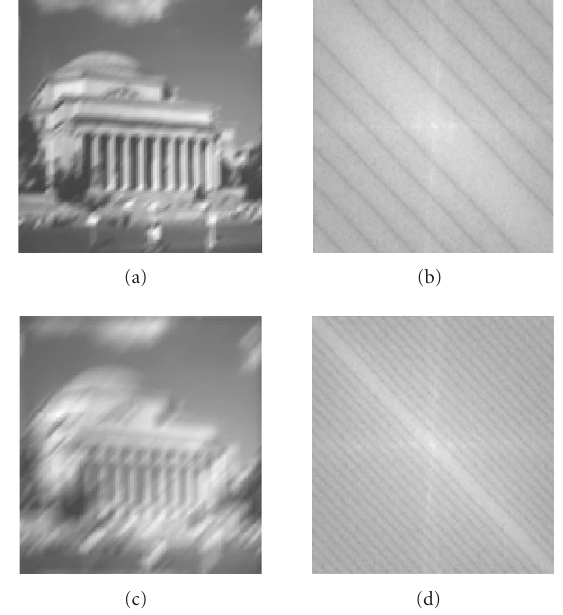
Figure 3: (a) A motion blurred image with L = 10 pixels, φ = 45 ◦ , (b) Fourier spectrum of (a), (c) motion blurred image with L = 30 pixels, φ = 45 ◦ , (d) Fourier spectrum of (c). The sizes of (a) and (c) are 256 × 256 pixels.